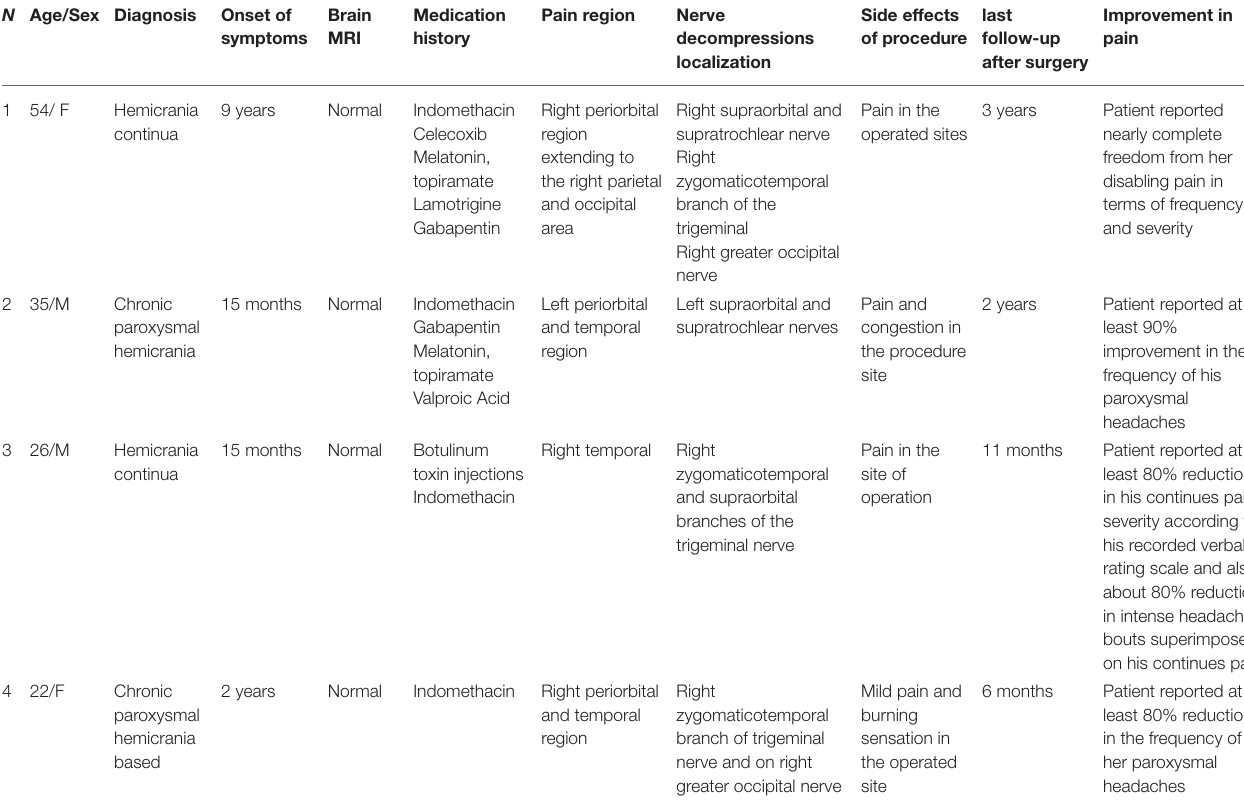
TABLE 1 | Main information of the cases. N Age/Sex Diagnosis Onset of